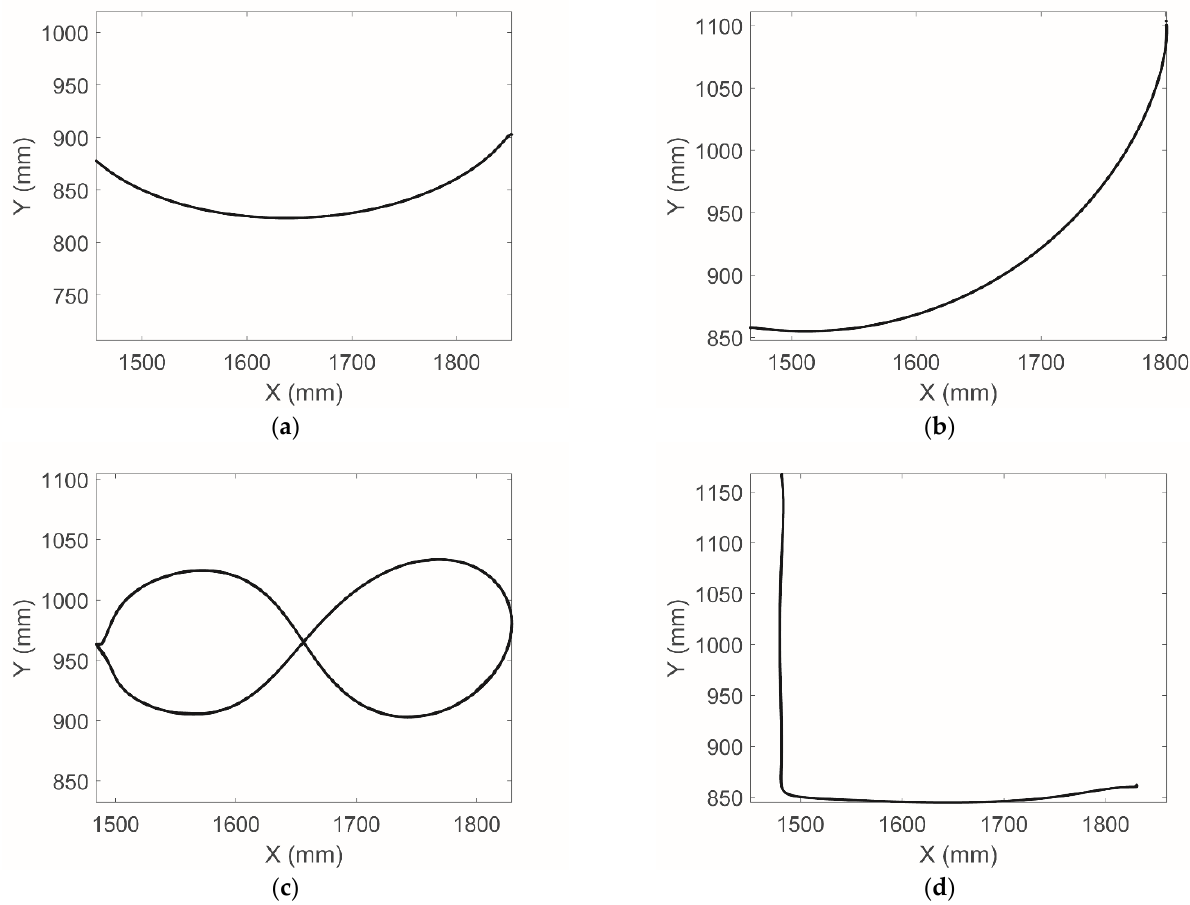
Figure 4. Trajectories for upper limb rehabilitation: ( a ) Trajectory 1; ( b ) Trajectory 2; ( c ) Trajectory 3; ( d ) Trajectory 4.